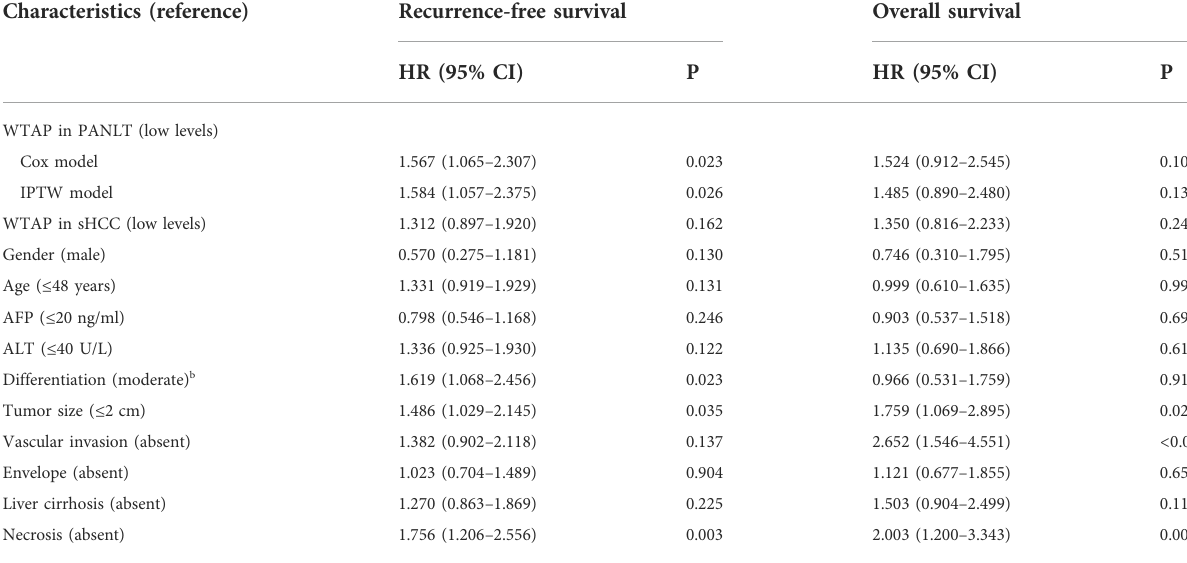
TABLE 2 Multivariate analysis for recurrence-free survival and overall survival in small HCC patients. a